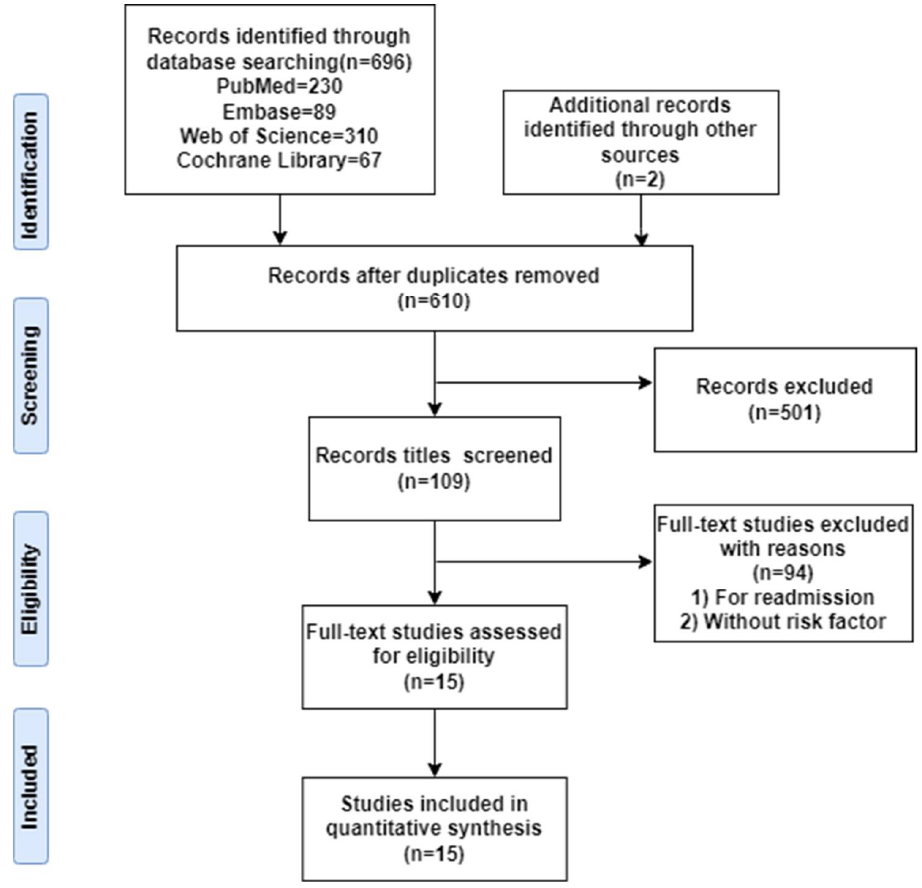
Figure 1. PRISMA flowchart.